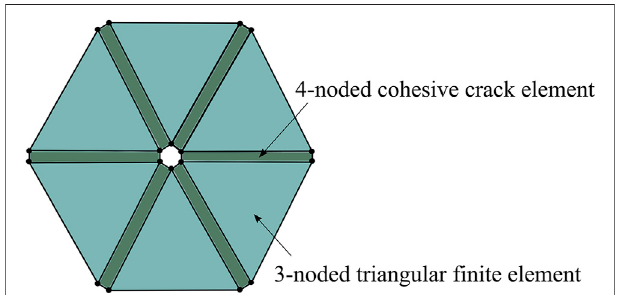
FIGURE 2 | The continuum was discretized using cohesive elements interspersed throughout a mesh of triangular elements.